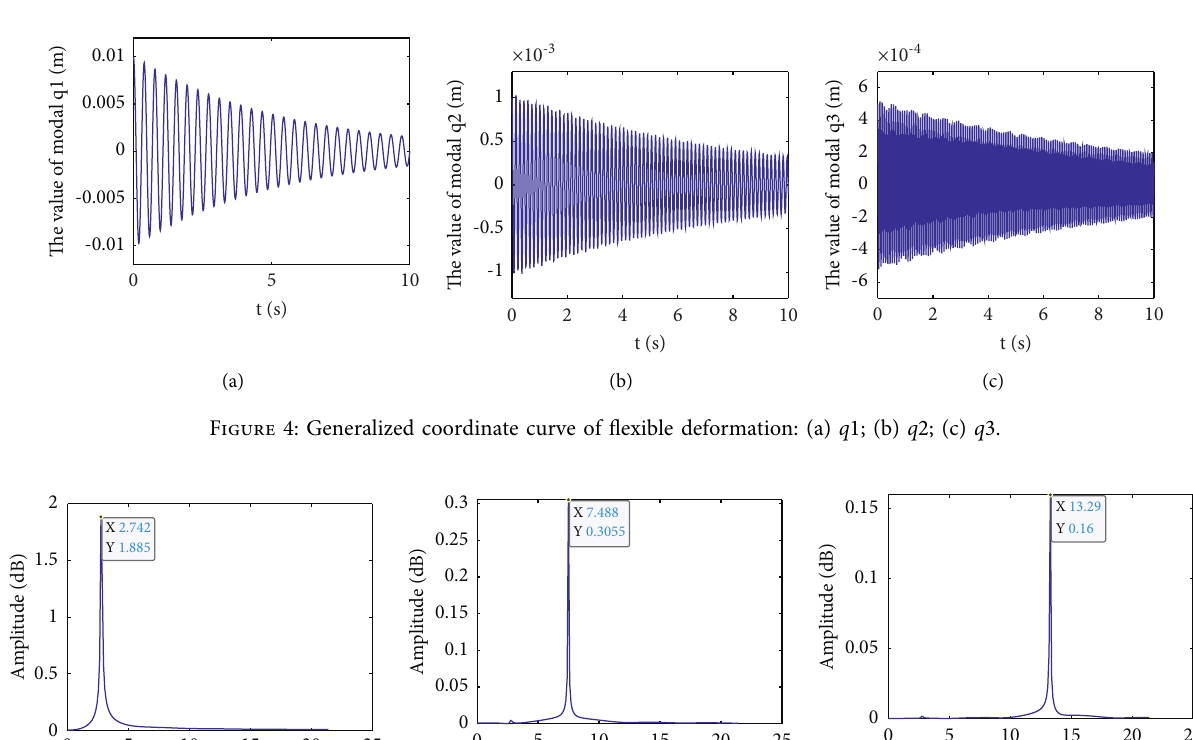
1 ; (b) spectrum of q 2 ; (c) spectrum of q 3